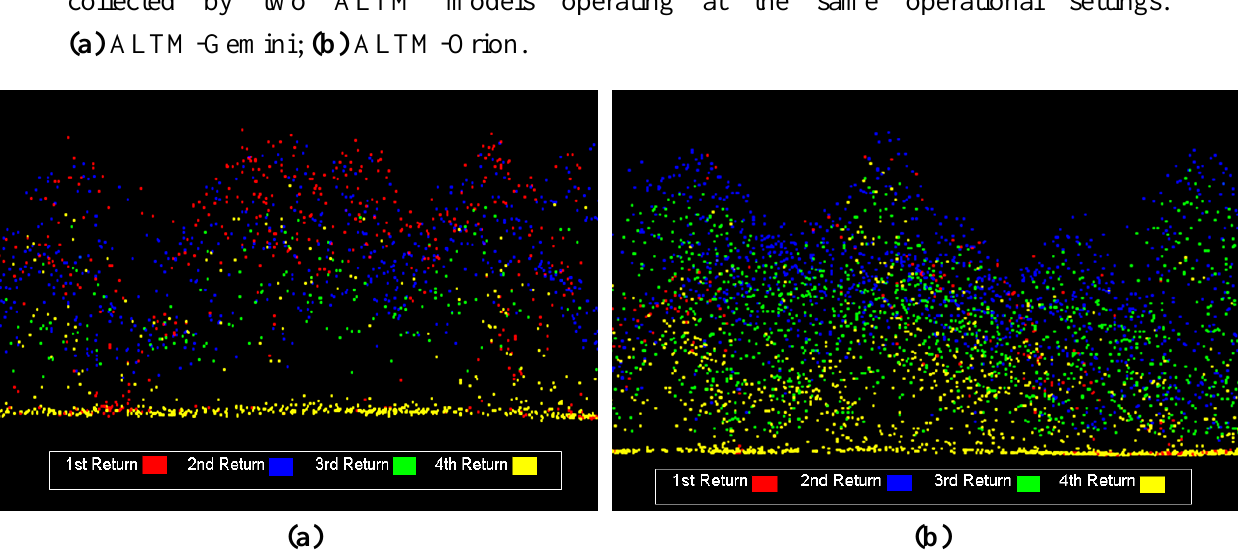
Figure 4. Vegetation canopy of 15–17 m average height represented by multiple return data collected by two ALTM models operating at the same operational